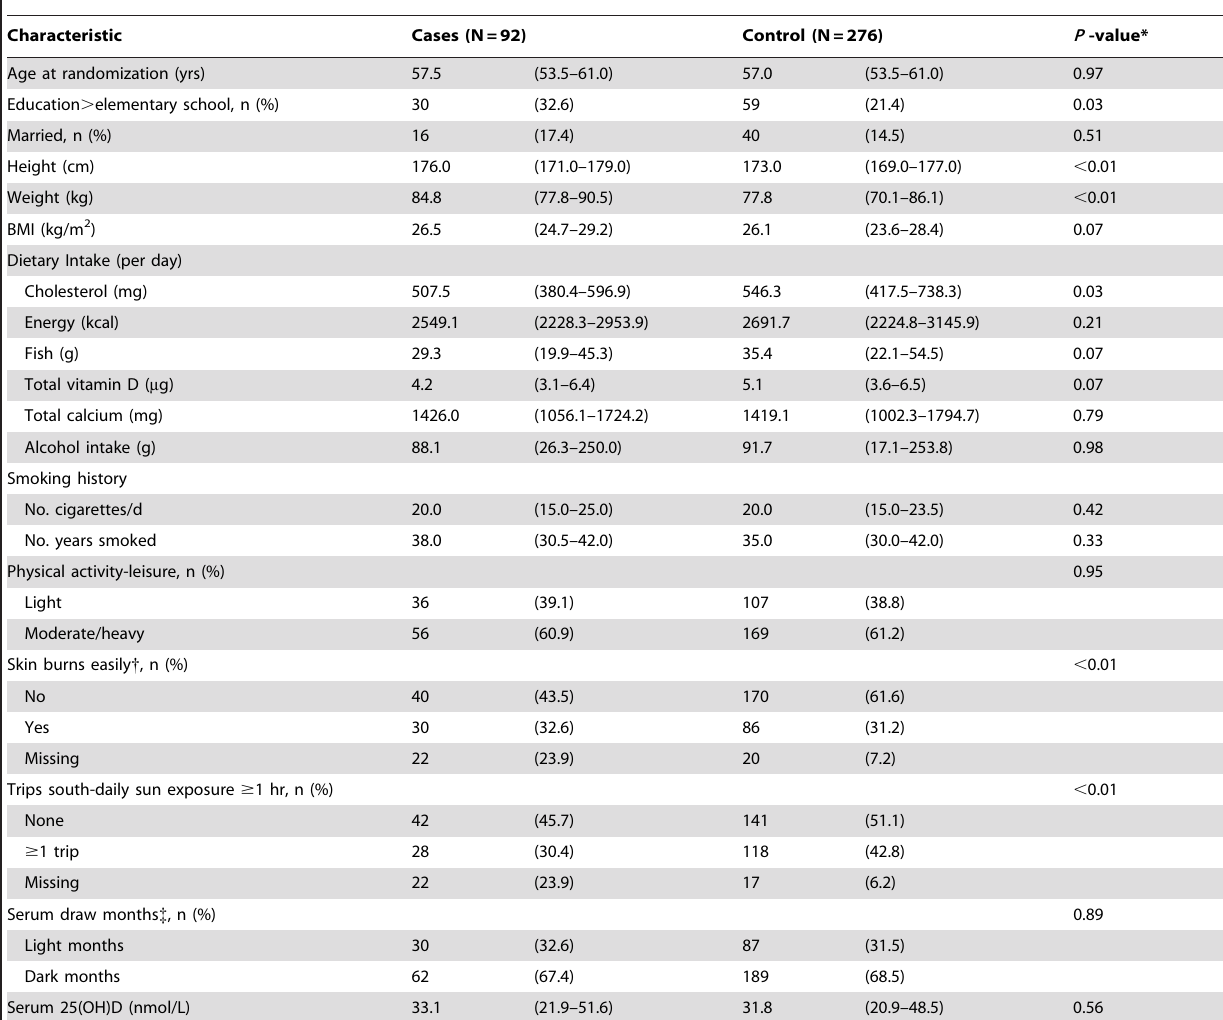
Table 1. Baseline characteristics of men, ATBC